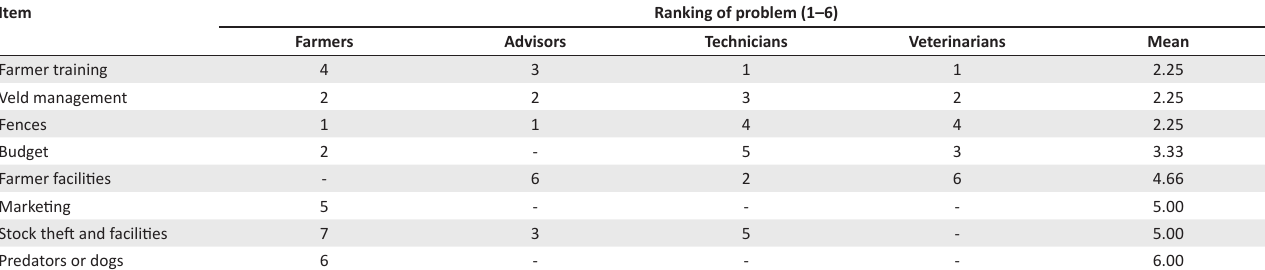
TABLE 12: Ranking of problems and solutions.